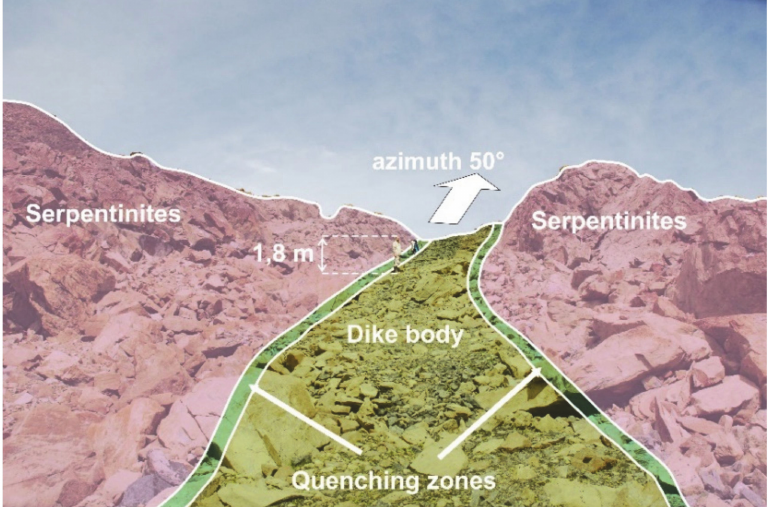
Figure 4. Photograph of the field relationship between the gabbro-diabase dike and serpentinized mantle peridotites (east flank of the